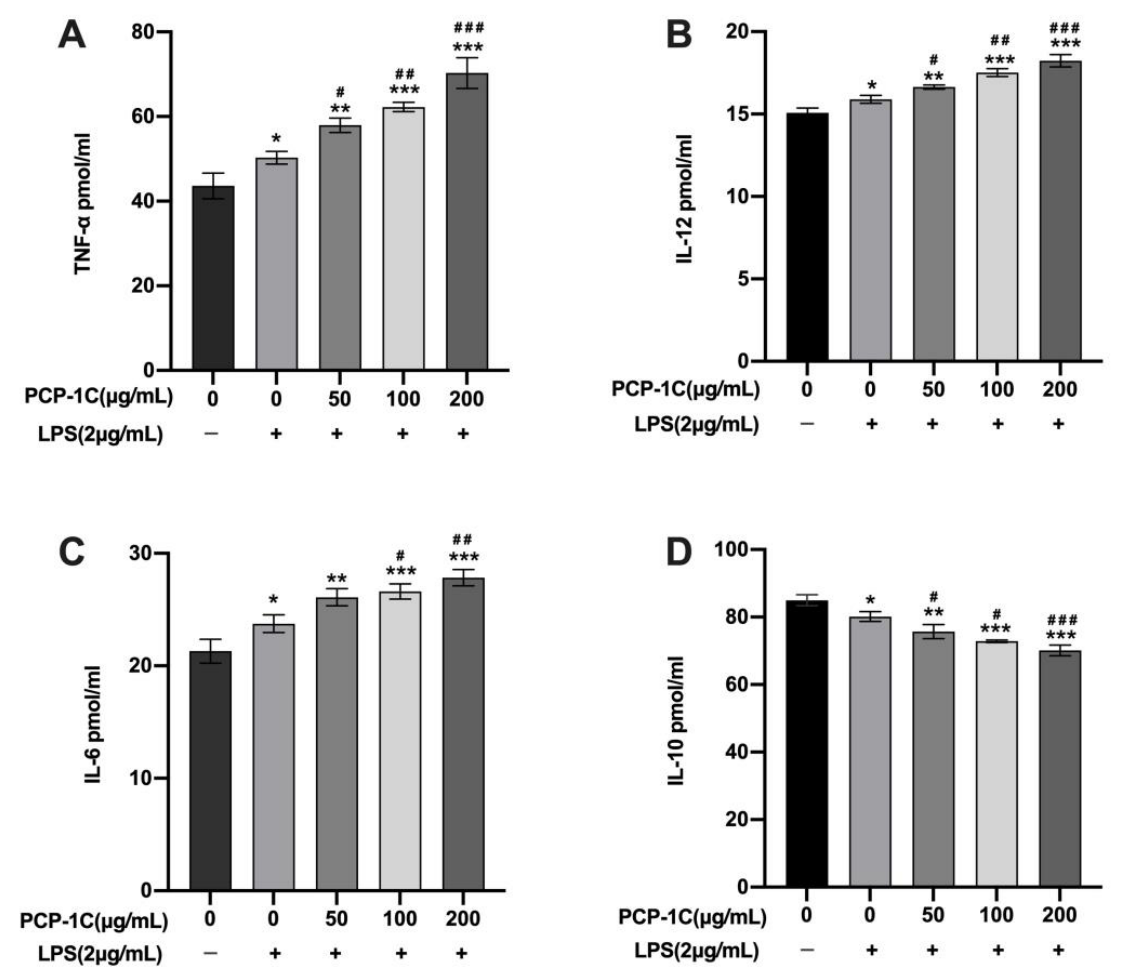
Figure 5. ELISA to detect macrophage cytokine levels. Macrophages were polarized at 50 µ g/mL, 100 µ g/mL, and 200 µ g/mL PCP-1C and/or 2 µ g/mL LPS for 24 h. Detected levels of cytokines TNF- α ( A ), IL-12 ( B ), IL-6 ( C ), and IL-10 ( D ) by ELISA. * p < 0.05, ** p < 0.01, *** p < 0.001 vs. Control, # p < 0.05, ## p < 0.01, ### p < 0.001 vs. LPS; “+” indicates the cells were treated with LPS, while “ − ” indicates they were treated without LPS.